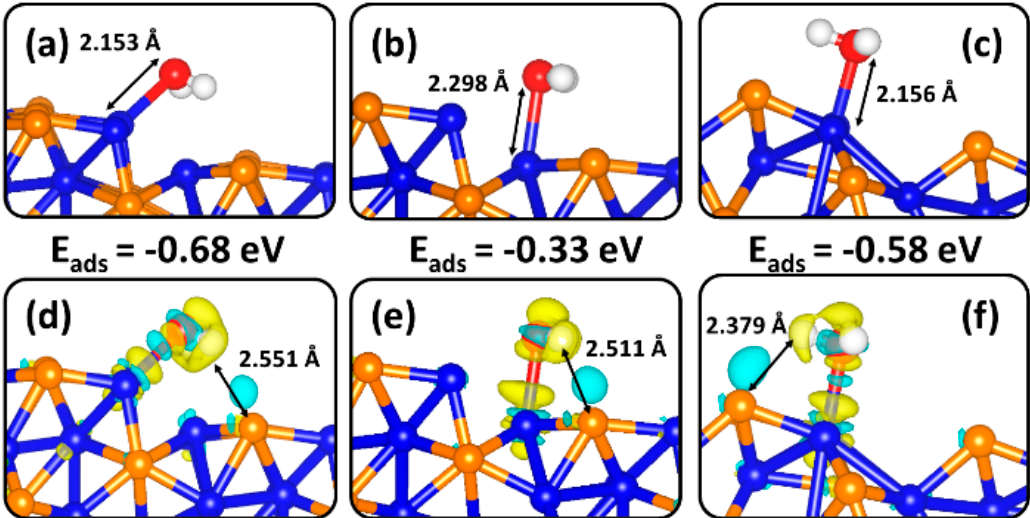
Figure 4. The most favourable, fully relaxed binding conformations of molecular H 2 O on the ( a , b ) Ni 2 P- and ( c ) NiP-terminations of the (1010) surface. The corresponding isosurfaces contours of the difference in charge density for an adsorbed H 2 O molecule are shown in ( d – f ). The cyan and yellow contours indicate electron density accumulation and depletion by ± 0.003 e / Å 3 , respectively.